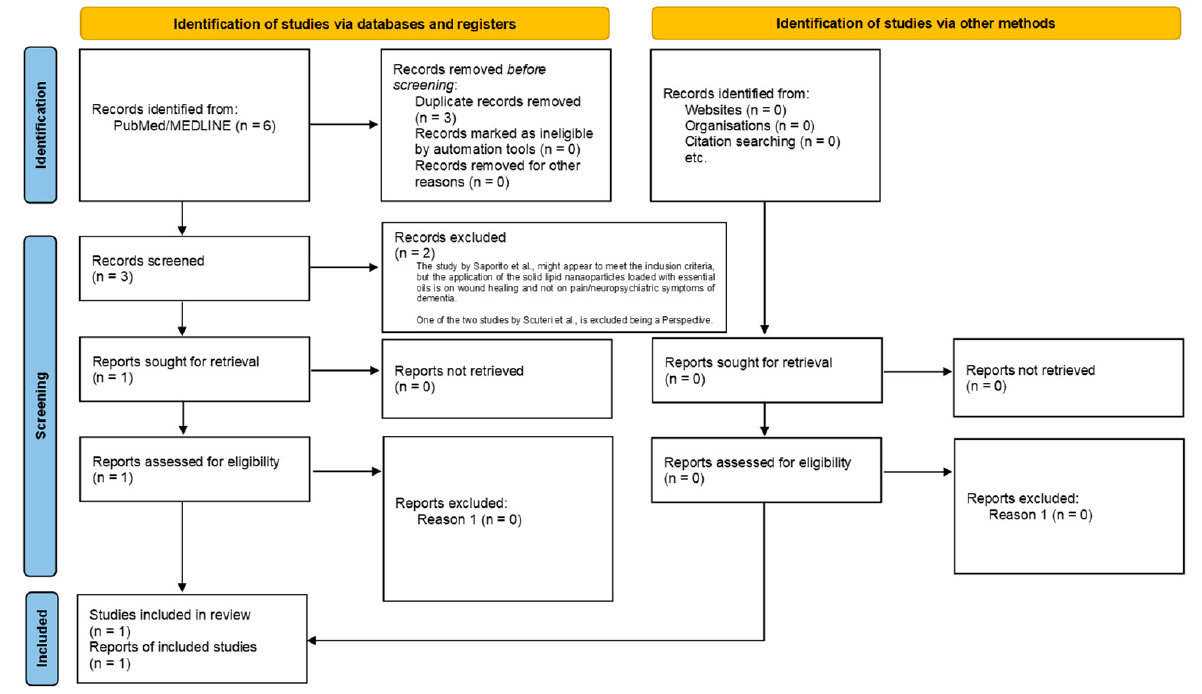
Figure 2. Process of search, selection and identification of the studies according to the Preferred Reporting Items for Systematic reviews and Meta ‐ Analyses extension for Scoping Reviews (PRISMA ‐ ScR).